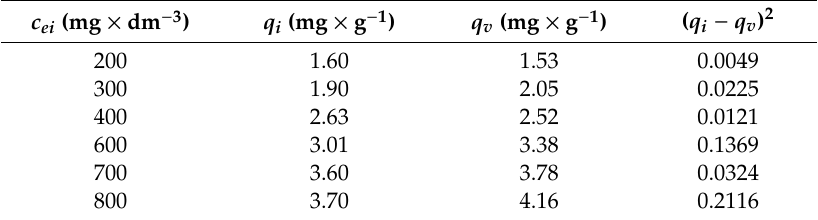
Table 4. The adsorbed amount and calculated adsorption